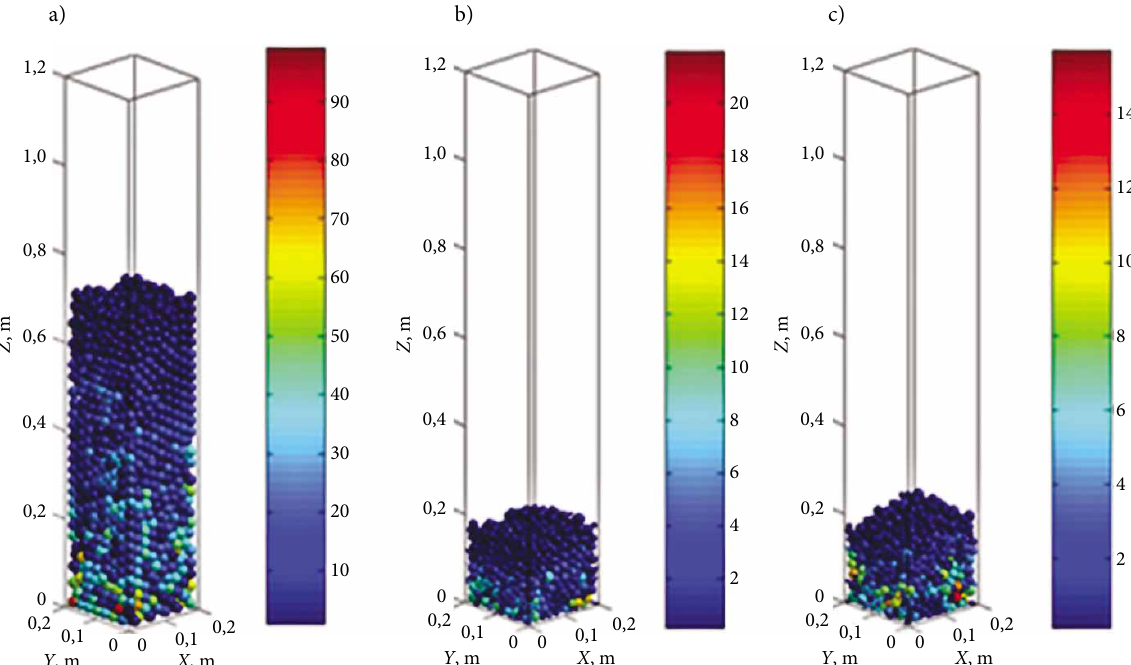
Fig. 8. Colour charts of the contact forces of particle mixtures: a – monodispersed particle mixture with no friction; b – polydispersed particle mixture with no friction; c – polydispersed particle mixture with friction